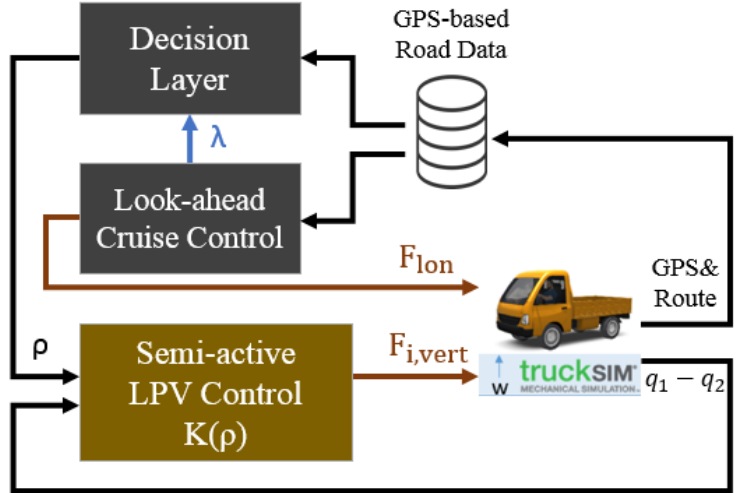
Figure 6. Integration of the